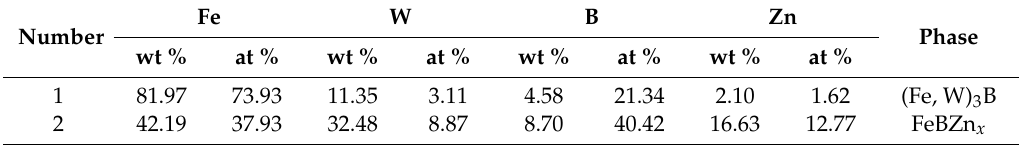
Figure 10. ( a ) The relationship of the average thickness of reticular borides of all the alloys and ( b ) the SEM results of reticular borides of A0, A2, A5 and A7 alloys in the transition zone after 3 days of immersion in liquid zinc with the addition of W. Table 3. Chemical composition of the transition region in alloy A2 analyzed by EPMA in Figure 10.